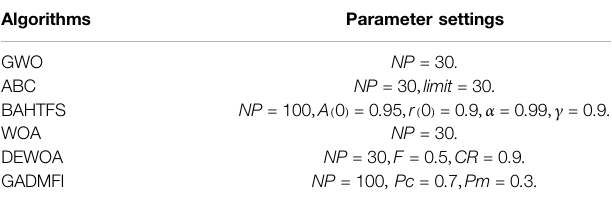
TABLE 4 | The private parameters of the algorithms. Algorithms Parameter